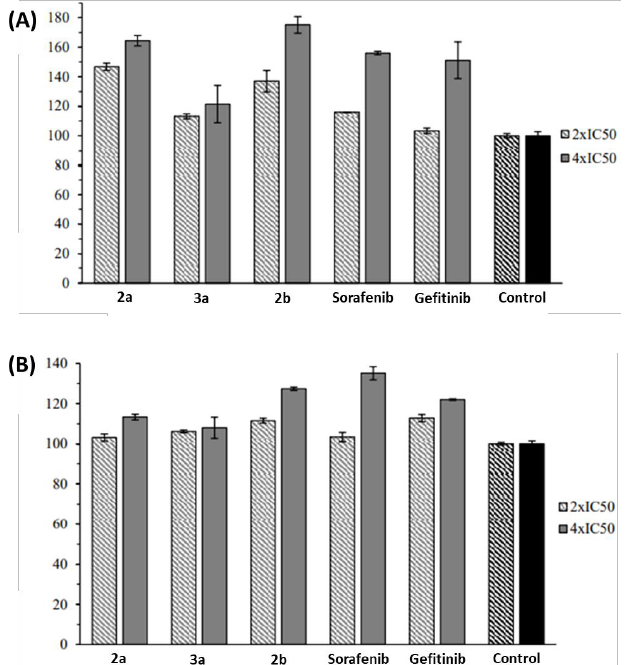
Figure 5. Caspase 3/7 activation by 2a , 2b and 3a in HCT-116 wildtype ( A ) and p53-knockout cells ( B ) after 24 h. Sorafenib and gefitinib (100 μ M and 200 μ M in wildtype cells) were used as positive controls. y-axis: caspase-3/7 activity in % with control set to 100%. n = 3 ± SD.